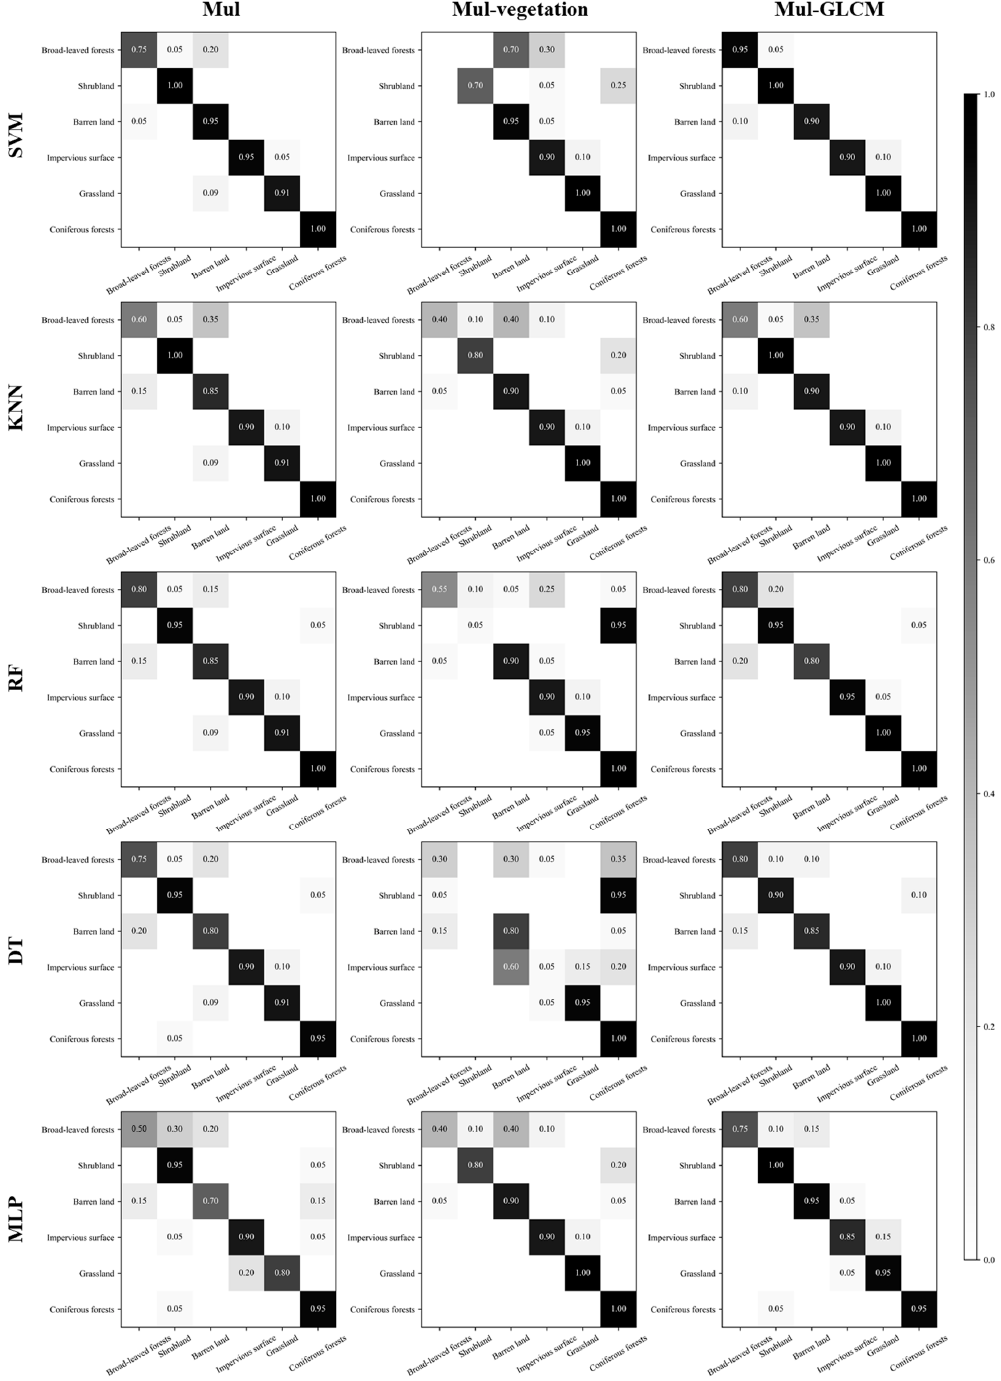
Figure 6. There are four classification algorithms of SVM, KNN, RF, DT and MLP in the horizontal direction, three features of Mul, Mul-vegetation and Mul-GLCM in the vertical direction, and a total of 15 confusion matrix results.